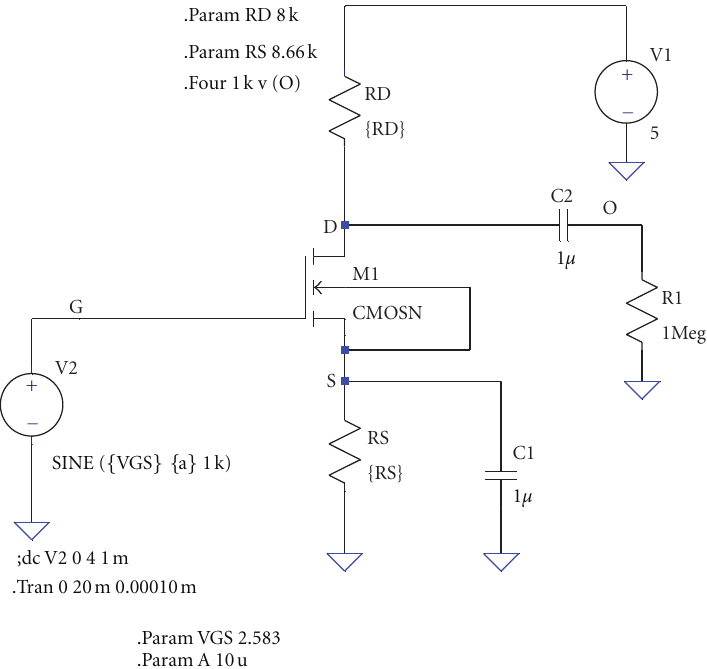
Figure 8: Common source with source degeneration, bypass capacitors, and load resistances.